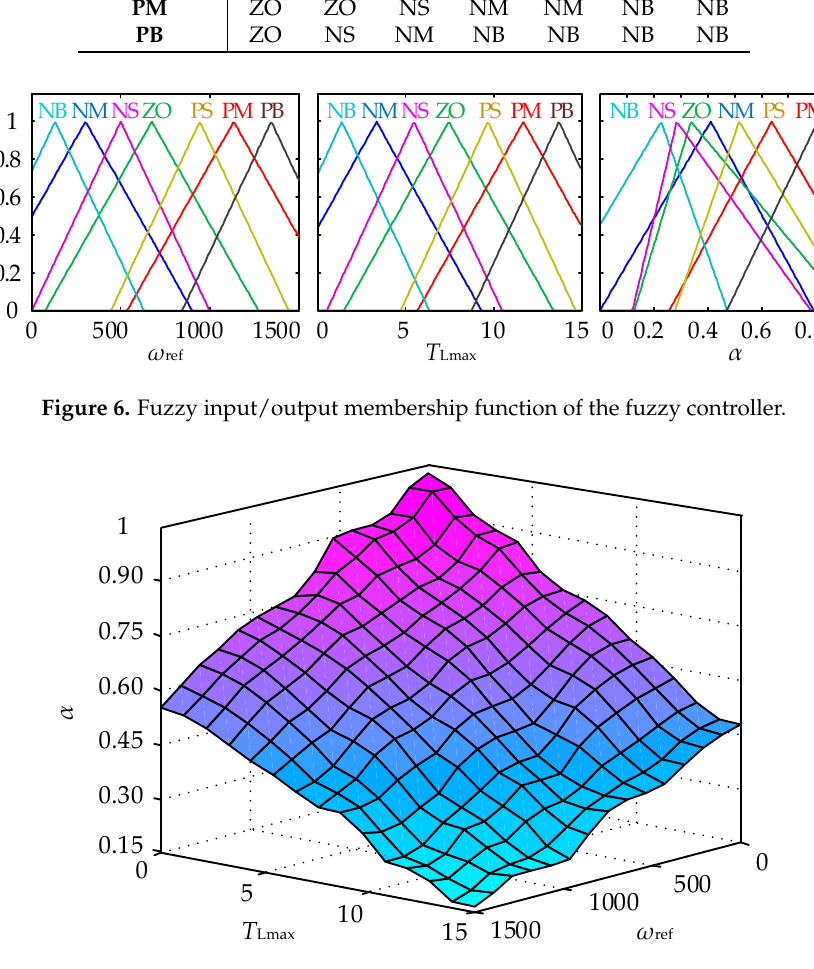
Table 2. Different operating conditions that correspond to Figure 8.